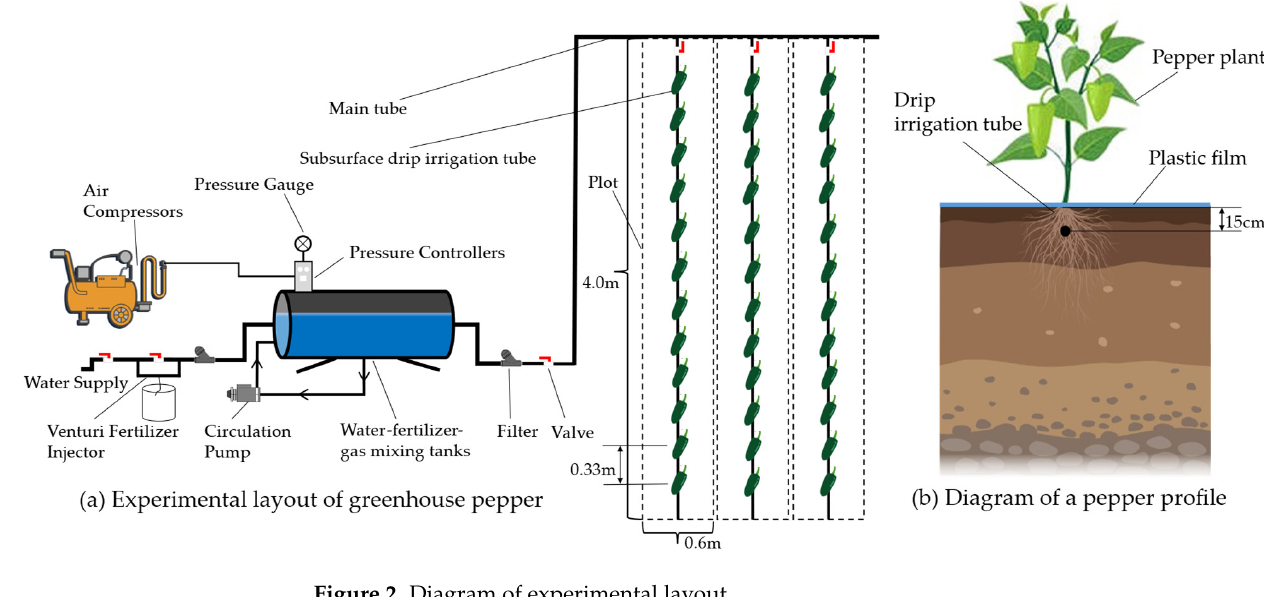
Figure 2. Diagram of experimental layout.